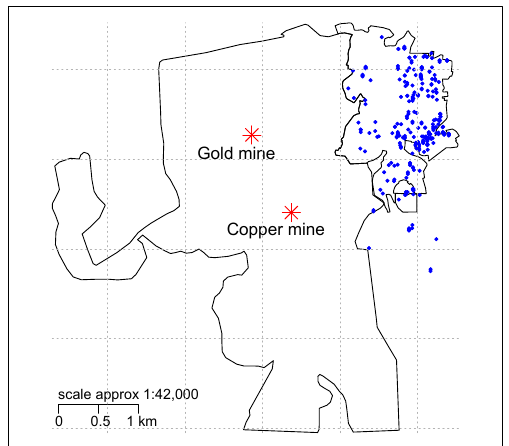
Figure 1. Geographical position of the gold and copper mines and child’s residence. Original positions were changed using jitter to keep